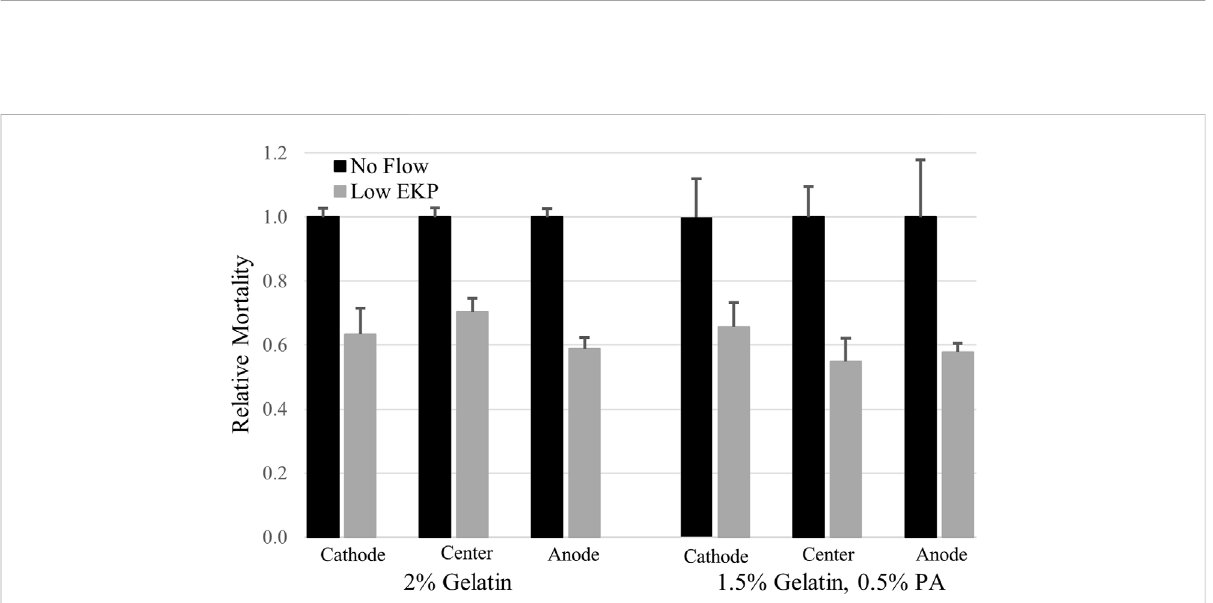
FIGURE 5 Low rates of electrokinetic perfusion (EKP) through 3D cultures reduced cell mortality. Current density of 32.4 mA/cm 2 generated an EOF rate of 0.7 μ m/s in the low charged 2% gelatin and signi fi cantly reduced mortality in all three regions of the 1.7 cm long channel ( p < 0.001 for all three regions). Current density of only 5.8 mA/cm 2 generated an EOF rate of 0.6 μ m/s in the 1.5%:0.5%, gelatin:PA mixture and signi fi cantly reduced cell mortality ( p < 0.03 cathode, p < 0.003 center, p < 0.04 anode) compared to the cells in the absence of fl